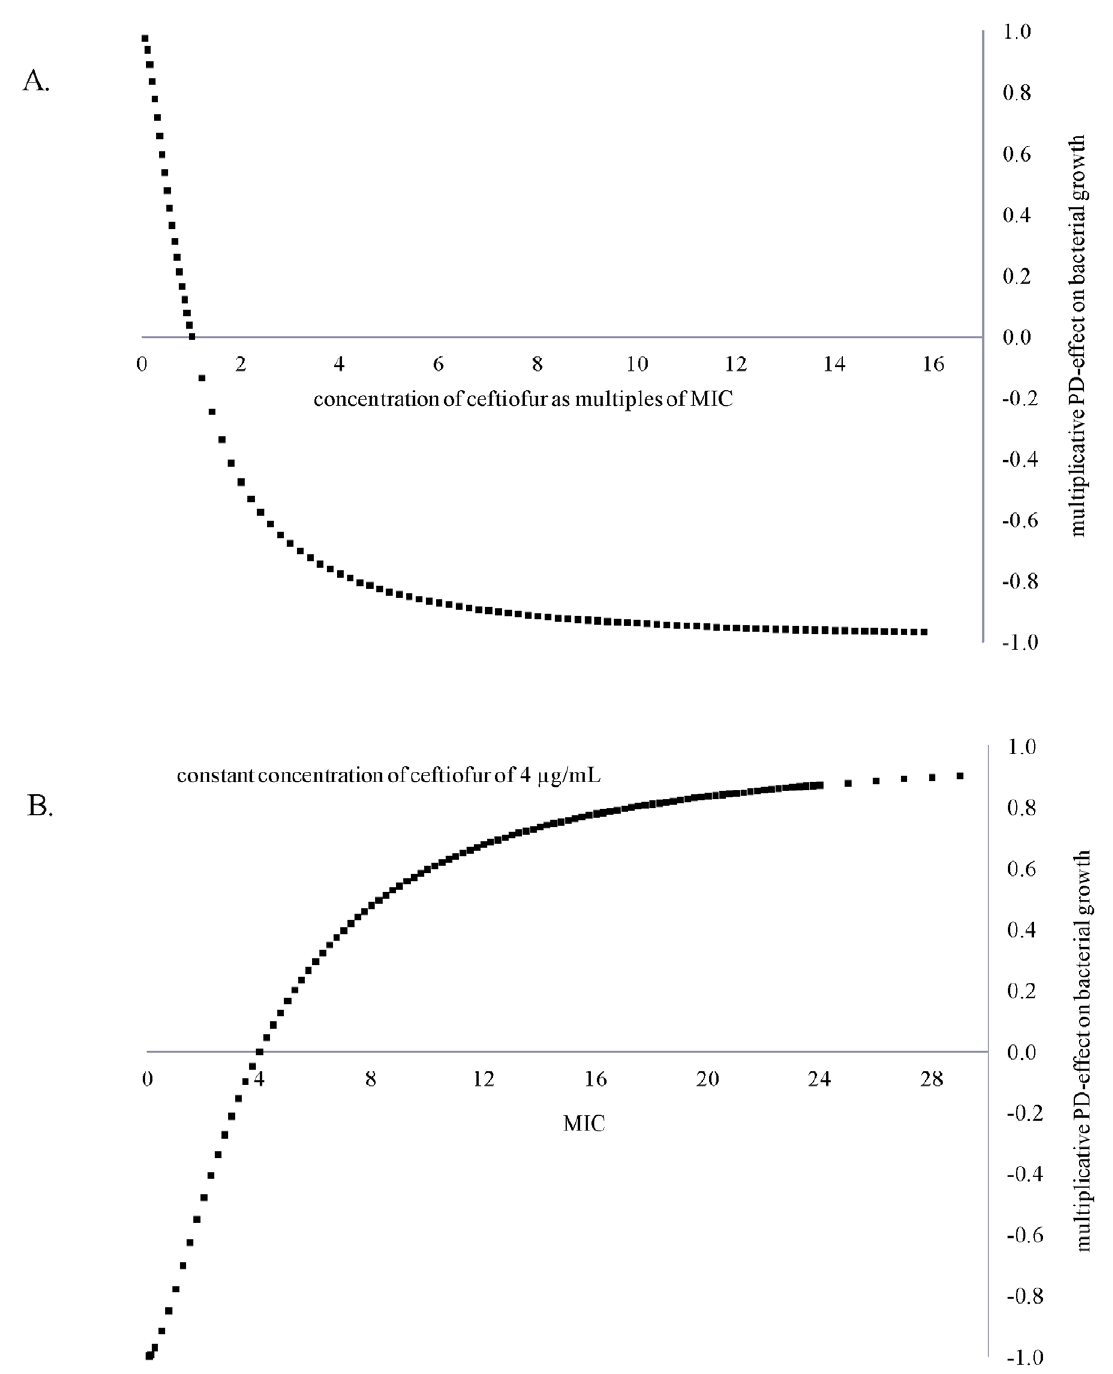
Figure 2. Pharmacodynamic model. A. Multiplicative pharmacodynamic effect on E. coli net growth with a constant minimum inhibitory concentration (MIC=1 m g/mL) and changing ceftiofur concentration expressed as multiples of MIC; Hill coefficient=1.5. B: Multiplicative pharmacodynamic effect on E. coli net growth with changing MIC and a constant ceftiofur concentration; Hill coefficient=1.5.